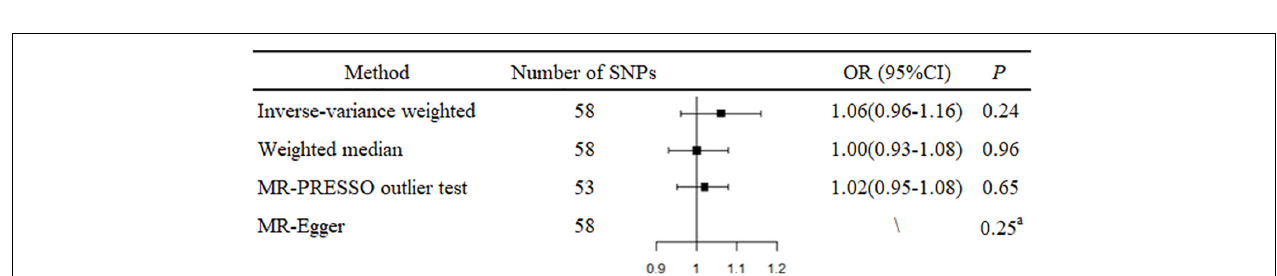
FIGURE 1 | An overall design of the present study. MR, Mendelian randomization; MR-PRESSO, MR Pleiotropy RESidual Sum and Outlier; and SNP, single-nucleotide polymorphism.